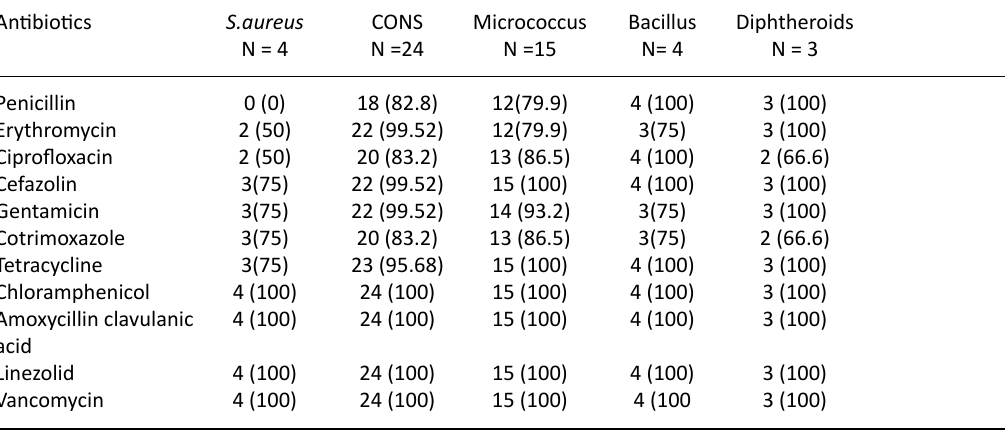
table 2. Antibiotic sensitivity pattern of Gram positive bacteria isolated from ICU Antibiotics S.aureus CONS Micrococcus Bacillus Diphtheroids N = 4 Penicillin 0 (0) Erythromycin Ciprofloxacin Cefazolin 3(75) Gentamicin Cotrimoxazole Tetracycline Amoxycillin